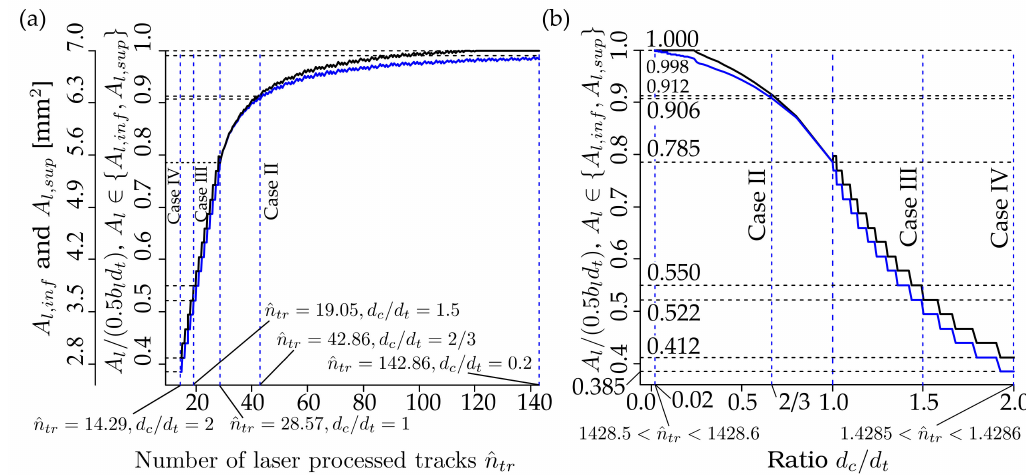
Figure 12. The dependencies of the bounds of the cross-section of the laser-processed metal A l , inf and A l , sup and the ratios A l , inf / ( 1/2 b l d t ) and A l , sup / ( 0.5 b l d t ) on the number of tracks ˆ n tr and ratio d c / d t of the considered plate; see Figure 1: ( a ) when ˆ n tr ∈ [ 14.29, 142.86 ] , corresponding (cid:104) (cid:105) to d c ∈ 1.4 × 10 − 4 ,1.4 × 10 − 3 or d c / d t ∈ [ 0.2, 2 ] ; and ( b ) when d c / d t ∈ [ 0.02,2 ] , corresponding to (cid:104) (cid:105) d c ∈ 1.4 × 10 − 5 ,1.4 × 10 − 3 or ˆ n tr ∈ [ 14.286, 1428.571 ]